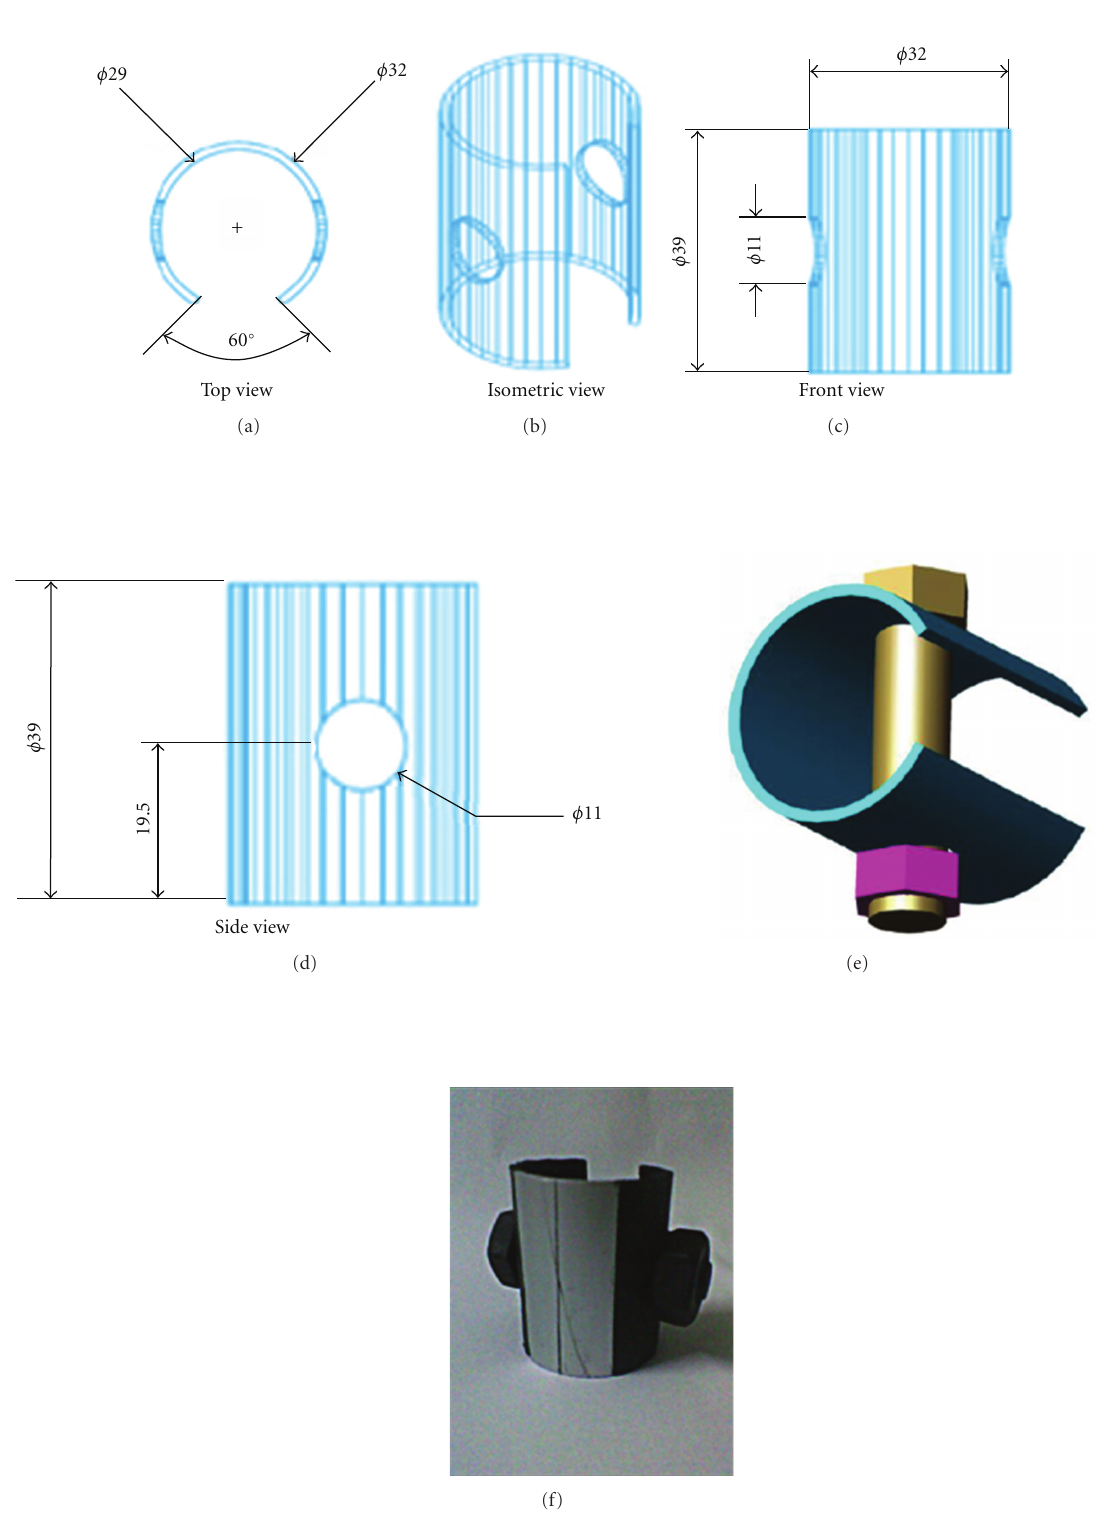
Figure 2: Appearance of C-ring specimen. Away from the areas of interest, coating was applied to avoid